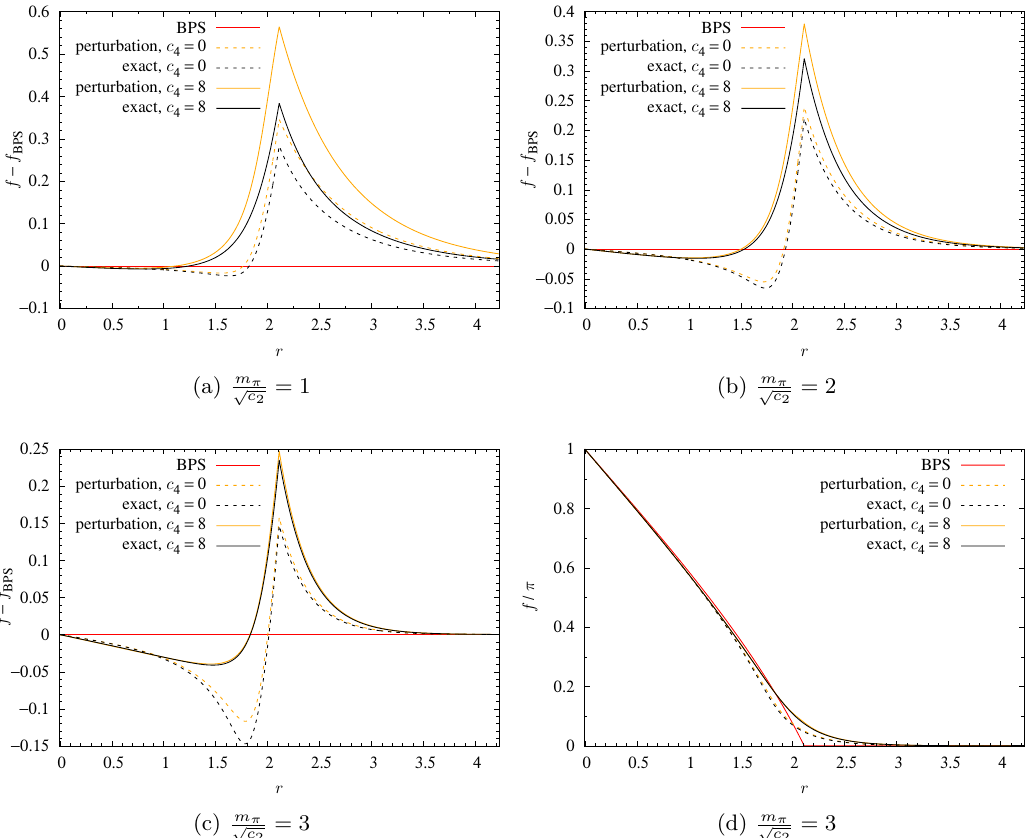
Figure 2 . The profile function f = f BPS + δf at N 2 LO using linearized equation of motion in the BPS-Skyrme model with ( s, p ) = (1 , 2) , for c 4 = 0 , 8 and m π = 1 , 2 , 3 . The other parameters of the model has been set as: c 2 = 1 , c 6 = 1 , µ = 1 and hence the compacton radius R = (3 π ) 1 3 ’ 2 . 112 2